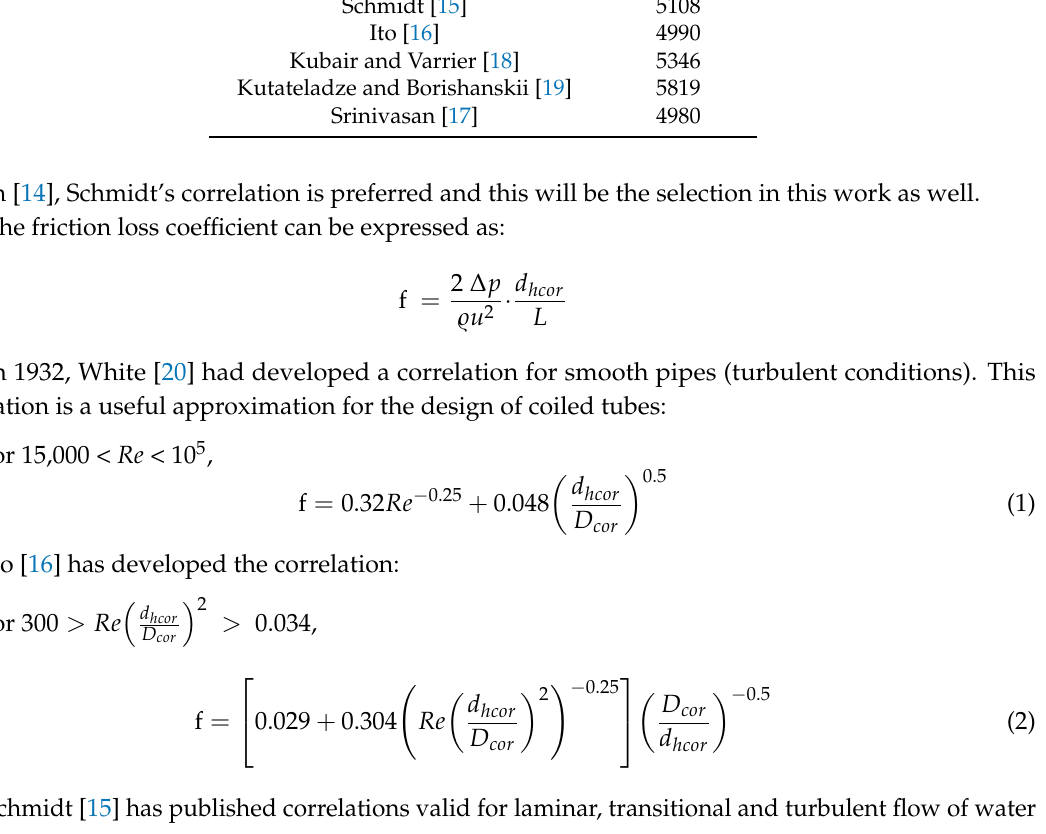
Table 2. Critical Reynold numbers for helical ducts from different authors.